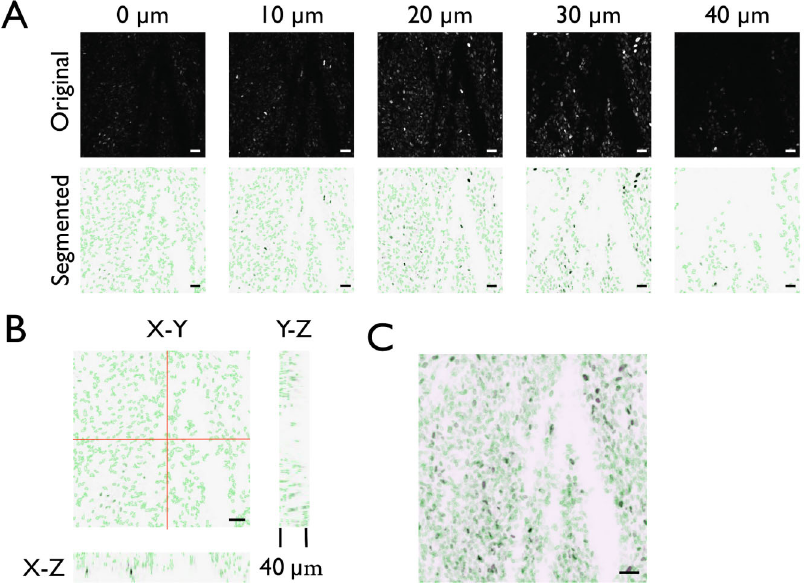
Figure 4. Cell segmentation on a high cell density Z-stack. A. Representative images from a typical intravital imaging Z-stack with H2B-Apple labeled nuclei (top row) and segmented regions identified from a negative of the original image using the described segmentation algorithm (bottom row; green outlines depict the segmented cell regions detected by the algorithm in each Z-slice). All scale bars represent 50 m m. B. Orthogonal views of the 3D Z-stack displaying segmented cell region outlines (green) in each view. C. Summation of the Z-stack containing all combined segmented region outlines (green).